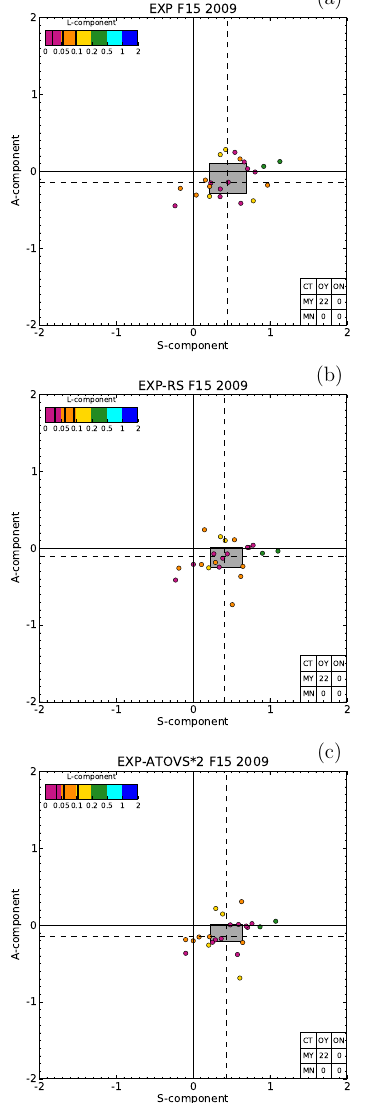
Fig. 11. Similarly to Figs. 9 and 10, SAL plots for the three ex- periments now selecting only 2009 cases, (a) control (EXP), (b) EXP-RS and (c) EXP-ATOVS*2.